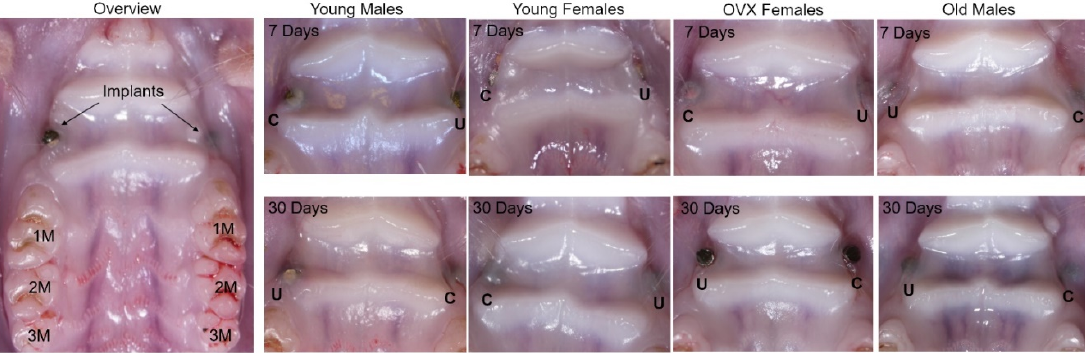
Figure 2. OM images of mucosal healing post implantation at 7 and 30 days in all demographic groups. Healing panel shows an overview of implant placement location relative to 1st, 2nd, and 3rd molar (1M, 2M, and 3M). Location of IonL-Phe-coated and uncoated implants are indicated by C and U, respectively.